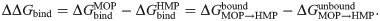
The thermodynamic cycle for computing the free energy difference between MOP and HMP upon binding to μOR: ΔΔGbind=ΔGbindMOP−ΔGbindHMP=ΔGMOP→HMPbound−ΔGMOP→HMPunbound.
The unbound state requires transformation of the ligands alone in solution, since the receptor is the same in both cases.